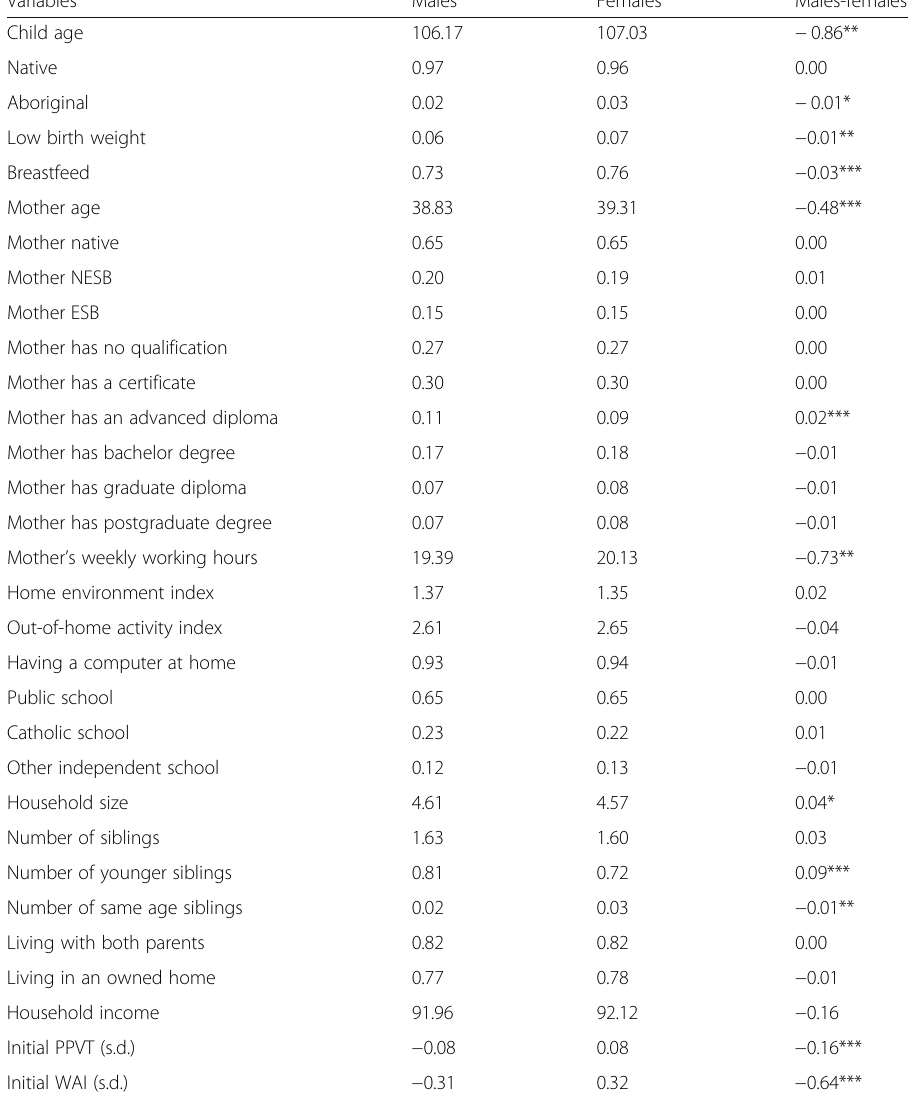
Table 1 Summary statistics by gender